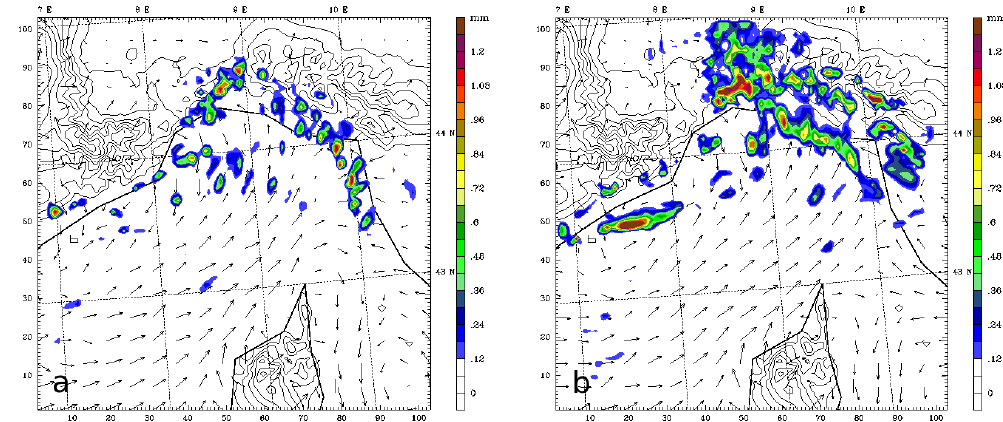
Figure 5. 1h accumulated precipitation (color-filled contours) and surface wind field (vectors) at (a) 00:00UTC (maximum wind vector 8.7ms − 1 ) and (b) 06:00UTC (maximum wind vector 9.7ms − 1 ) on 30 January 2008 for the GEN